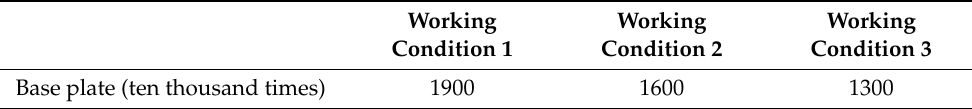
Table 7. The earliest cracking loading time of base plate under different working conditions.